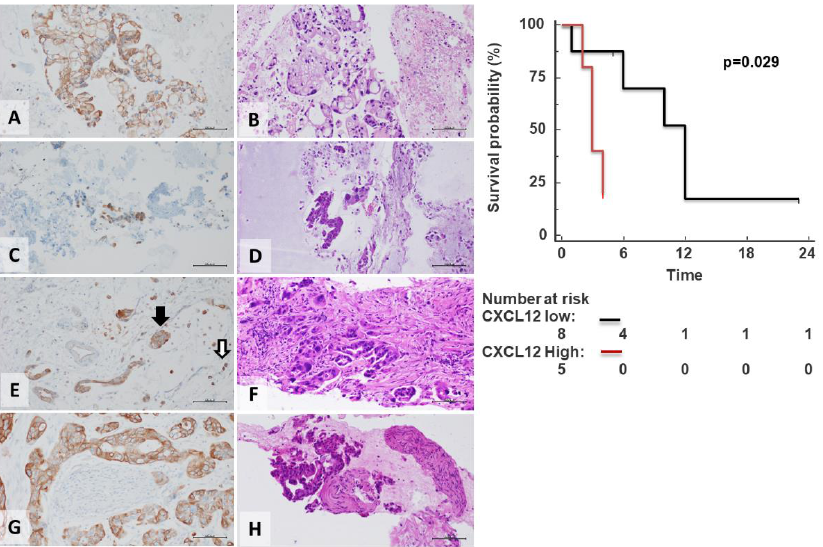
Figure 8. CXCL12 overexpression in FNAC-PDACs with poor prognosis. CXCL12 was predominantly identified in cancer cells. Representative microphotographs of membranous and cytoplasmic CXCL12 expression in PDAC FNAC ( A , C , E , G ) with related haematoxylin/eosin staining ( B , D , F , H ). CXCL12 high ( A ) and low cancer expression ( C ). Rare CXCL12-positive tumor-infiltrating was observed mainly surrounding monocytes/macrophages (white arrow), while robust cancer CXCL12 staining might be useful for visualizing tumor emboli (black arrow) ( E ) and PNI ( G ) (original magnification 200 ×). Follow-up was available for 13 patients. A total of 7 patients died (53.8%), showing a median overall survival of 6 months. The patients with a high sharp, consistent distribu- tion of CXCL12 expression showed short CSS with a median survival of 3 months, while low/negative CXCL12 expressing displayed short CSS with a median survival of 12 months ( p = 0.029) (Figure 8). 4. Discussion The role of the CXCR4-CXCL12-CXCR7 axis and PD-1/PDL-1 was addressed in tu- mor/stromal cells in 76 consecutive single-center patients undergone surgery between Jan- uary 2014/March 2015 and followed for 5 years until January 2021. We demonstrated that the entire axis CXCR4-CXCL12-CXCR7 was overexpressed in PDAC neoplastic cells as compared to TME cells. Moreover, CXCL12 significantly correlated with poor prognosis in an unrelated cohort of 20 FNAC from PDAC patients. CXCR4 was expressed by acinar cells and islets of Langerhans, surrounded by extensive dense fibrotic stroma or desmoplasia [34]. Trefoil Factor 2, an exocrine gene early expressed during mouse embry- onic development, induced CXCR4 activation in acinar cells promoting cell proliferation and preventing apoptosis [34]. CXCR4 was also detected in lymphocytic-monocytic infil- tration and endothelial cells [35] associated with vascular invasion [36]. Thus, it is possible to hypothesize that CXCR4 imaging might detect inflammatory and vascular involvement in PDAC and surgical/clinical settings [37,38]. CXCR7 is upregulated in tumor and stro- mal PDAC. Schwann cells, CXCR7 positive, were reported in pancreatic nerves and CXCR7-neutralizing antibody (9C4), but not CXCR4 inhibitor AMD3100, induced signifi- cant dose-dependent attenuation of transmigration toward PDAC cell lines [39]. Herein, CXCR7 expression was reported in nerve bundle, and CXCR7 expression of nerve bundle,